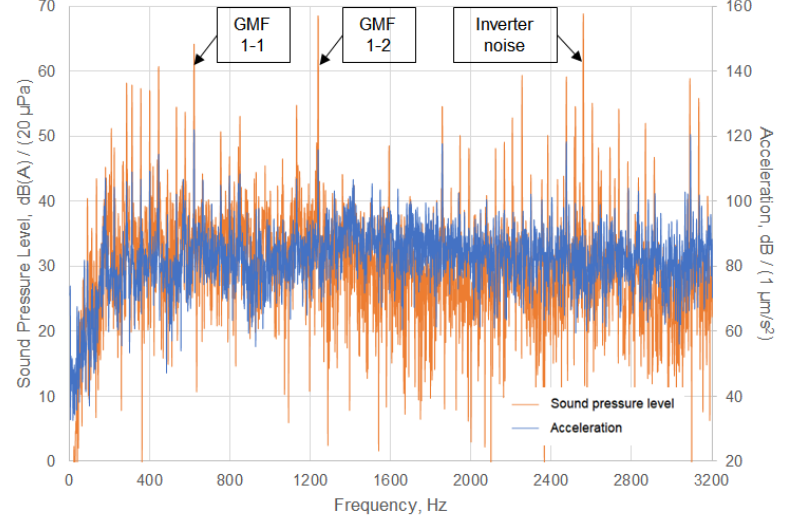
Figure 6. Frequency analysis of the noise and vibration at rated speed.